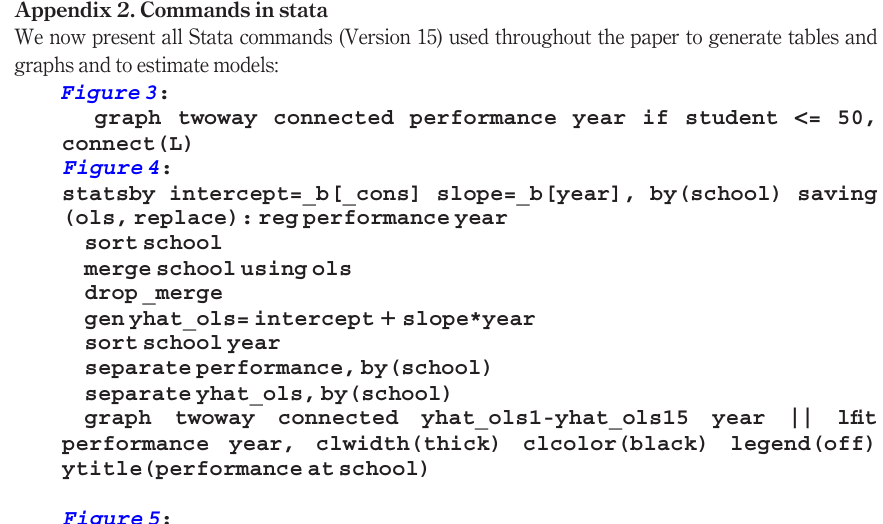
Figure 3 : graph twoway connected performance year if student < = 50,